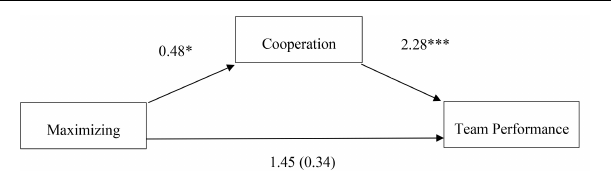
FIGURE 1 | Indirect effects of maximizing on team performance via cooperation. Indirect effect: 95% CI [0.20, 2.30]. ∗ p < 0.05, ∗∗∗ p < 0.001.